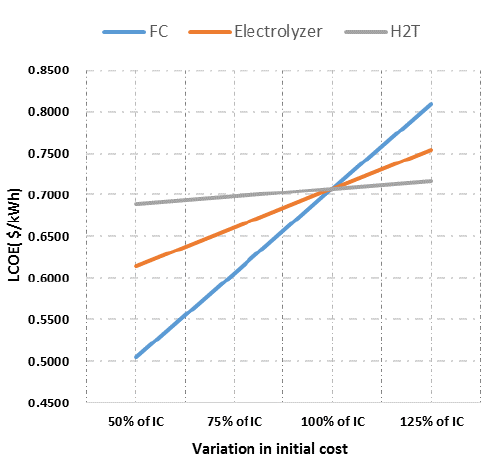
Fig. 8: The percentage of the optimized system components annualized costs in the TNPV